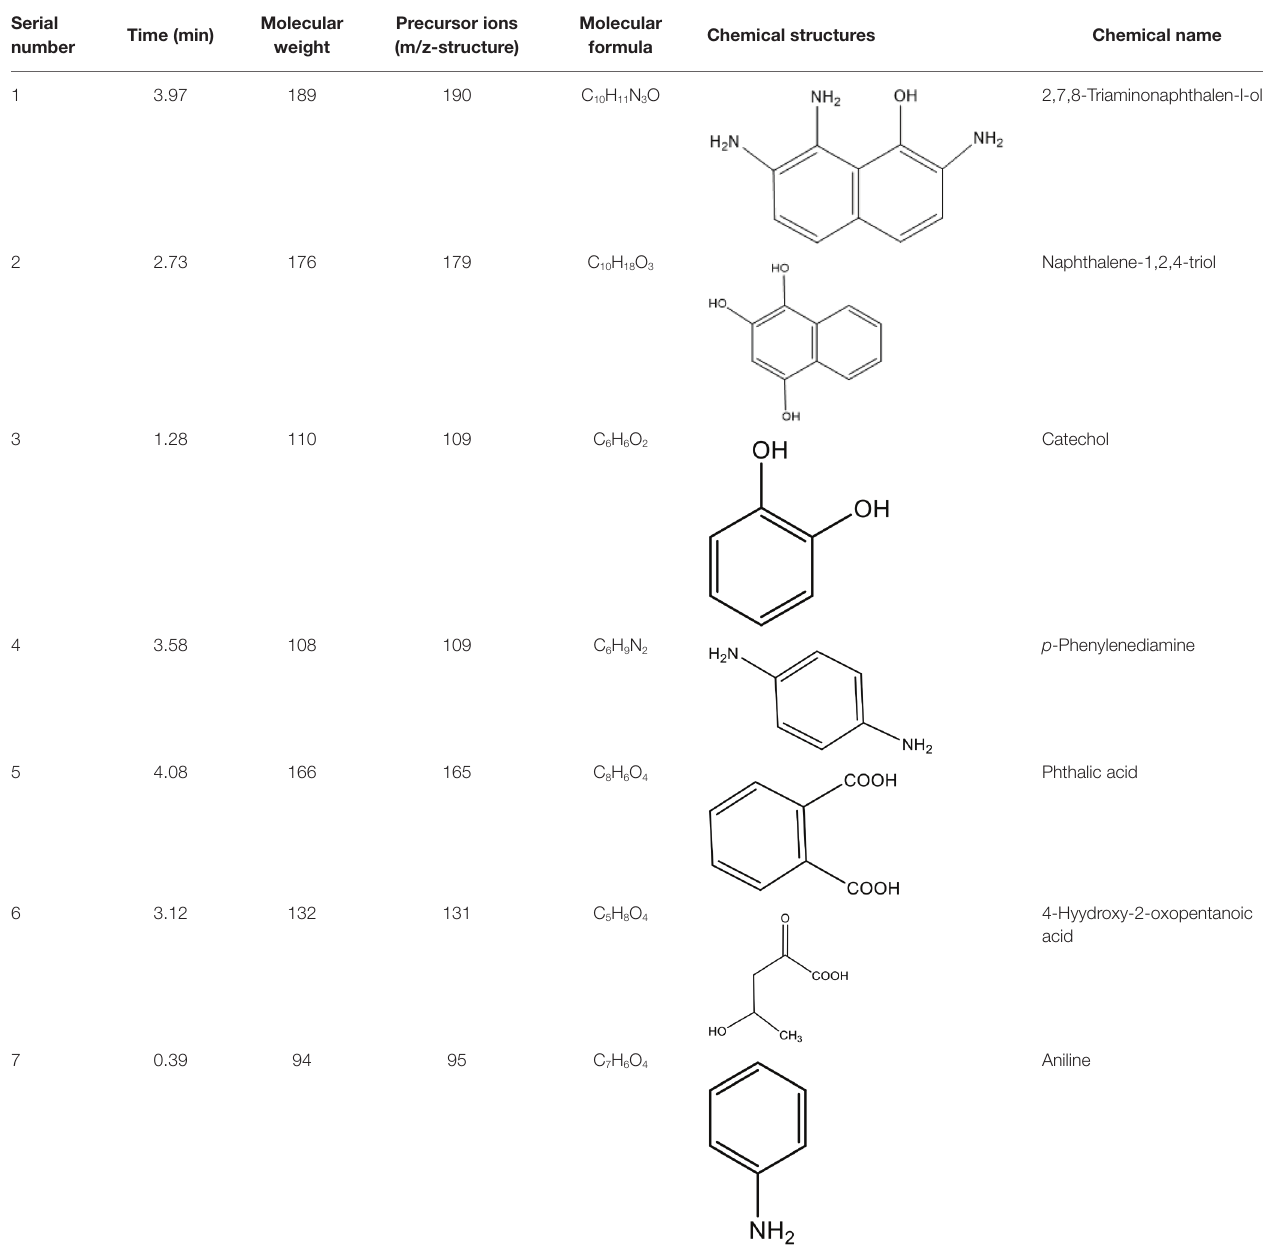
TABLE 4 | Characteristics of the main azo dyes used in this study. Serial Molecular Time (min) number